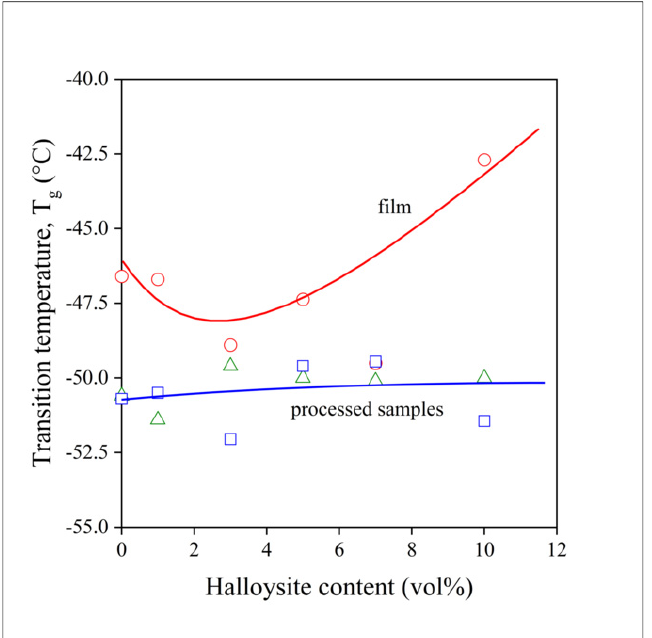
Figure 5. Glass transition temperature of PCL in PCL/halloysite composites determined by DMTA measurements from the maximum of loss tangent. Symbols: ( ) film, ( ) compressed, ( ) melt mixed.